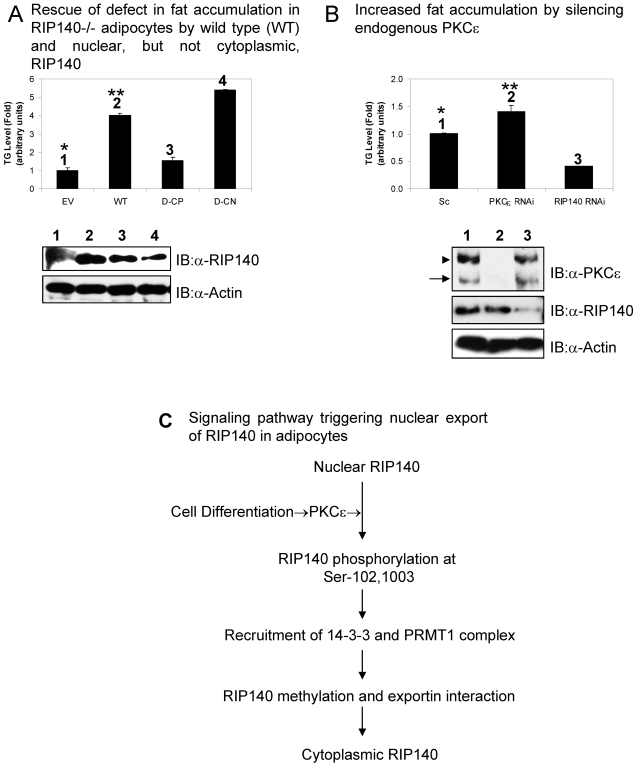
Physiological relevance of the sub-cellular distribution of RIP140 with respect to fat accumulation in adipocytes.(A) Gain of the nuclear (D-CN), but not the cytoplasmic RIP140 (D-CP), more effectively rescued the defect of fat accumulation in RIP140 null adipocyte cultures. **versus* p<0.05. (B) Loss of function of PKCε (to enhance nuclear RIP140) leads to higher levels of fat accumulation in differentiated adipocytes. **versus* p<0.05. (C) A schematic diagram depicting the signal transduction pathway of PKCε activation to the export of RIP140.